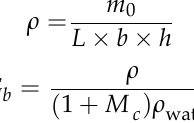
were tested in simply-supported bending with various concentrated loading configurations, and sixth point loading (Figure 3). Lateral supports were applied at every point of loading. which were employed to measure the deflection. As a control, bending tests with a center- point loading configuration and without lateral support were carried out. The formulae of E and S R with various loading configurations are summarized in Table